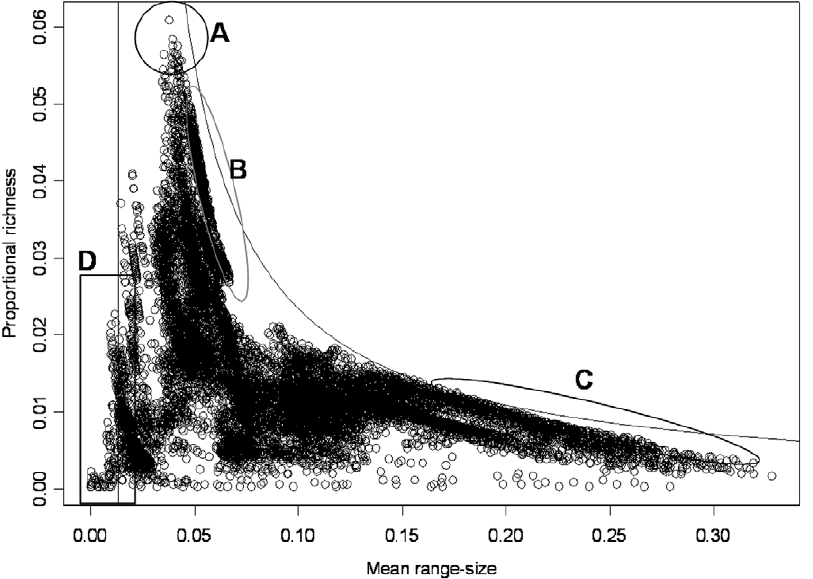
Figure 2. Range-diversity plot of the terrestrial mammals of the world. Data corresponds to a PAM of 16,420 cells of 10,000 km2, and 3,617 species. The vertical line is the proportional fill of the matrix, equal to 1 = b W =1/75.93. The curved line is obtained from equation (2) with maximum covariance=2.03 6 10 2 3 . Region (A) corresponds to the Colombian Choco´, (B) Northern South America, (C) Northern North America and Eurasia, and (D) Madagascar, the Philippines and the Malaysian Archipelago.